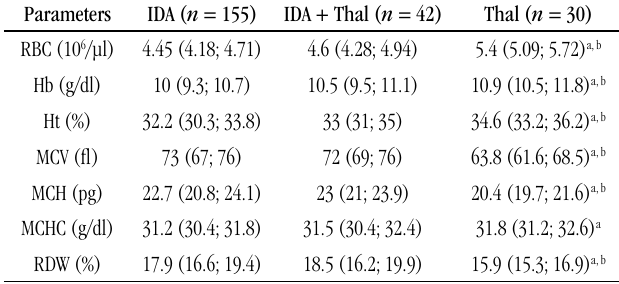
taBLE 2 − Hematological parameters of patients with iron deficiency anemia, iron deficiency anemia with concomitant thalassemia minor, and just thalassemia minor